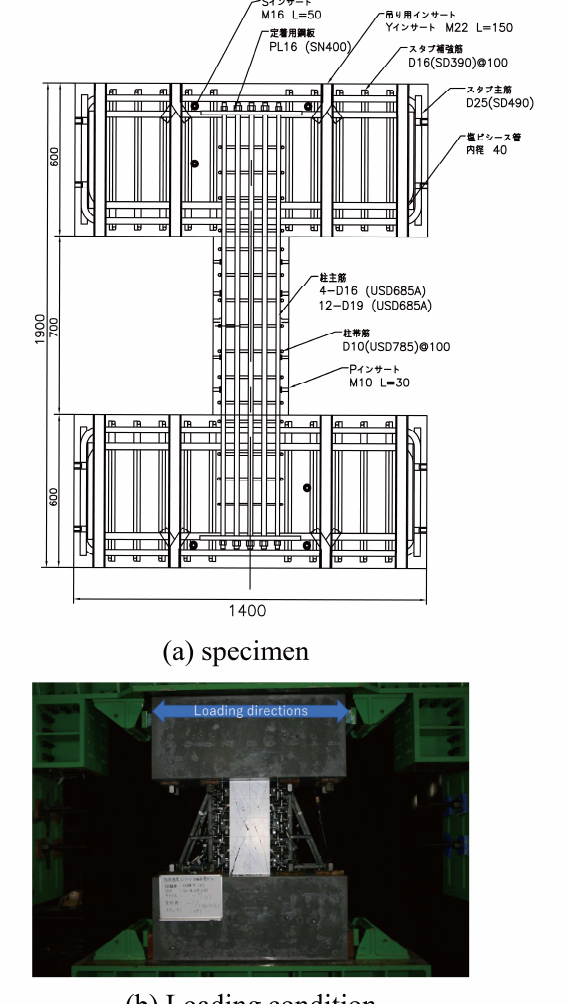
Figure 3. Experimental results of short RC column using ultra-high strength concretes: a) specimen, b) loading condition, c) shrinkage of the specimen, d) load-deformation relationships. After [34]. Note: (a) DXX means the deformed bar with the nominal diameter of XX mm. The high strength steel with the nominal strength of 685 MPa (USD685A) was used for main reinforcing bars and steel with the nominal strength of 785 MPa (USD785) was used for stirrups. (b) The setup and loading condition is similar to that of Fig.4 (b). (c) the column was separately placed to simulate the temperature history of the real size column by using heat insulator, and shrinkage of the specimen at the central part was measured by embedded strain gauge. Thermal expansion coefficient was assumed to be 10 μ/ ℃ . (d) Horizontal load is the load to push/pull the stab at the top of the column, and the bottom stab was fixed by prestressed steel rods. The deformation was the horizontal deformation at the top of column, as the measurment setup was shown in